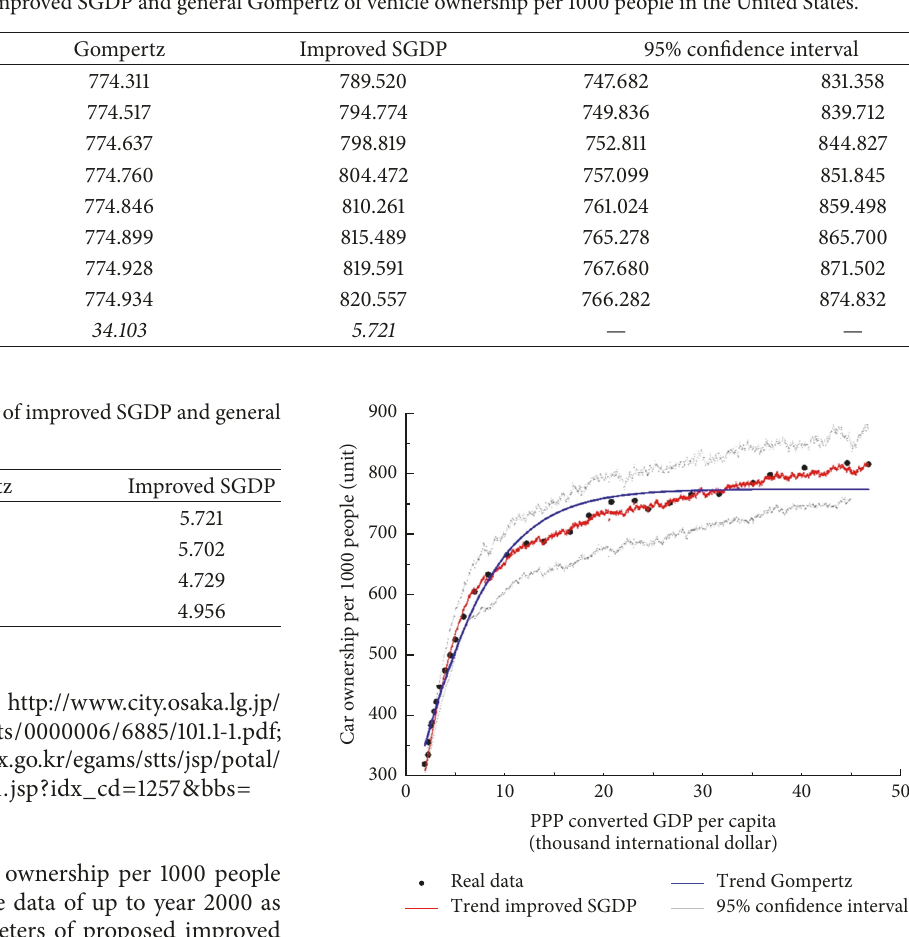
Table 2: Predict values by improved SGDP and general Gompertz of vehicle ownership per 1000 people in the United States.